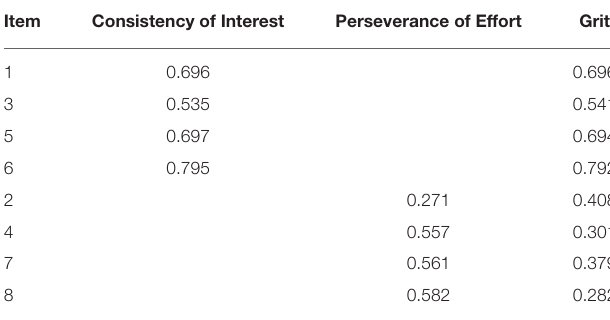
TABLE 5 | Factor Loadings for the Two- and One-Factor